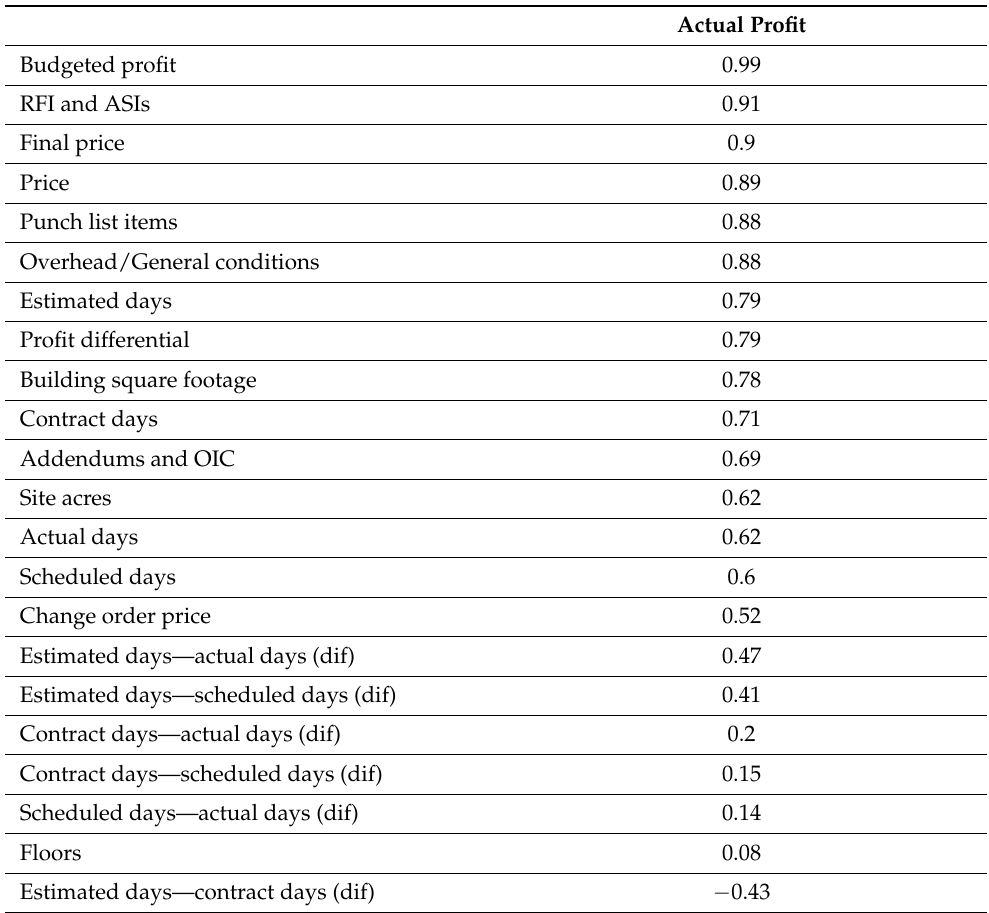
Table 7. Correlations for actual